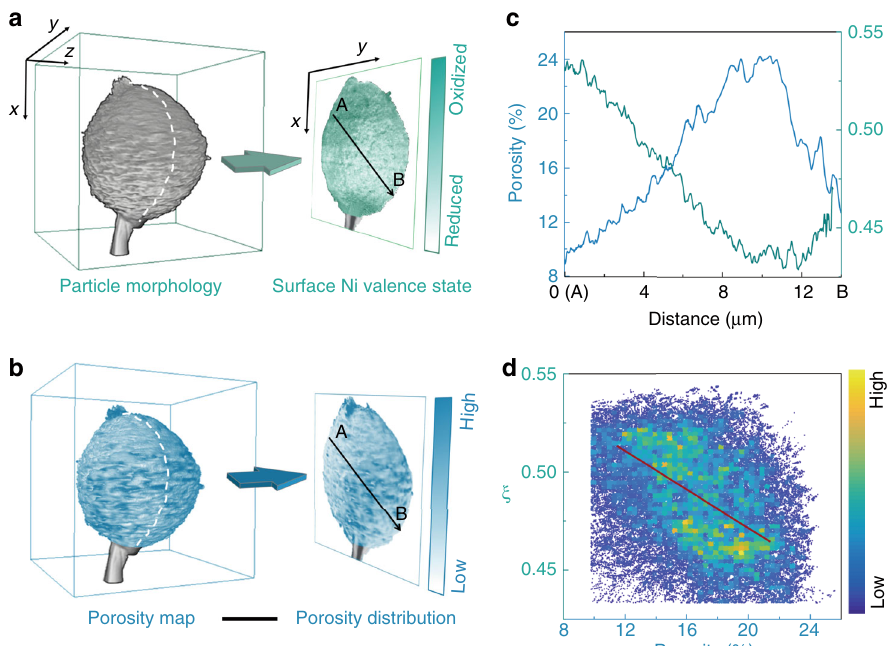
Fig. 3 The correlation between the local surface reconstruction and the bulk porosity. a The particle morphology and the surface (~5 nm depth) Ni valence state distribution. b The bulk porosity map. c The line pro fi le from points A to B as illustrated in a , b . The ξ is the ratio between the TEY intensity at 856.2 eV and the sum of that at 854.0 eV and 856.2 eV pixel by pixel, which represents relative Ni valence state. d The correlation plot for all the data points in a , b . The plot is color coded to the density of the data point (see colormap in the inset). A weak but clear negative correlation (see regression line in d ) is observed between the surface Ni valence state and the bulk porosity. The scale bar in b is 5 μ